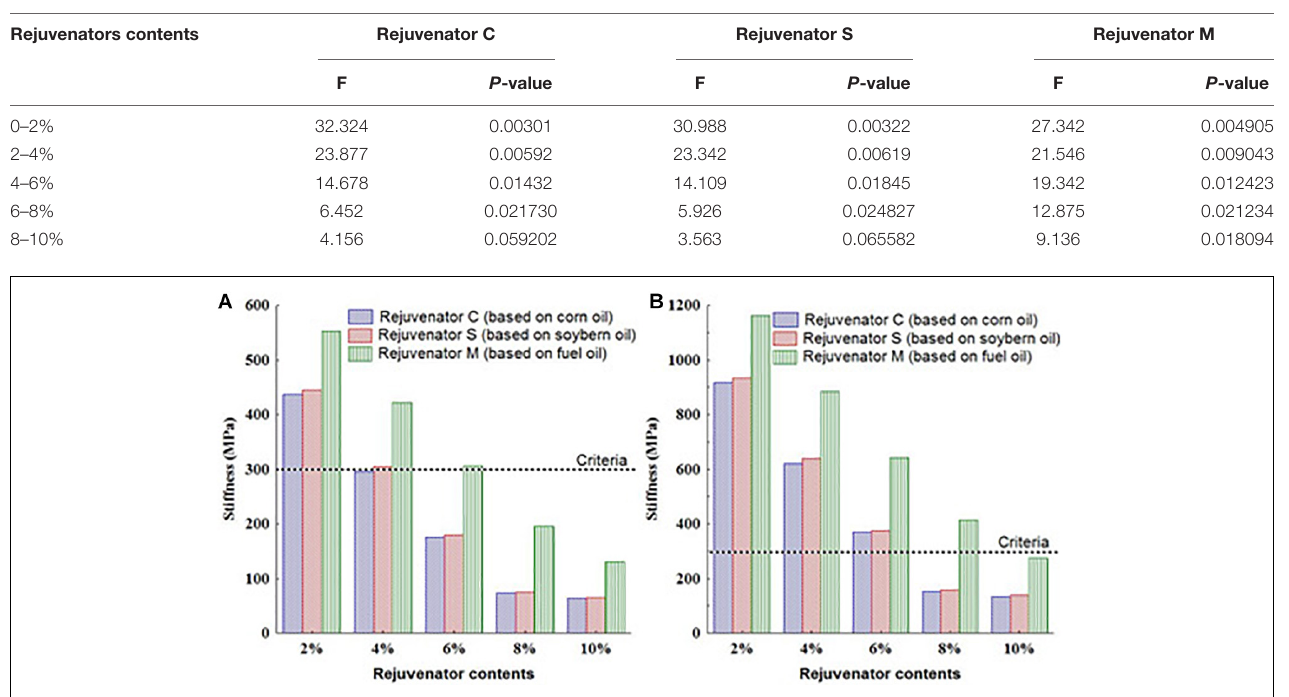
TABLE 9 | One-factor rejuvenator contents ANOVA on G*sin δ of recovered bitumen ( α = 0.05).